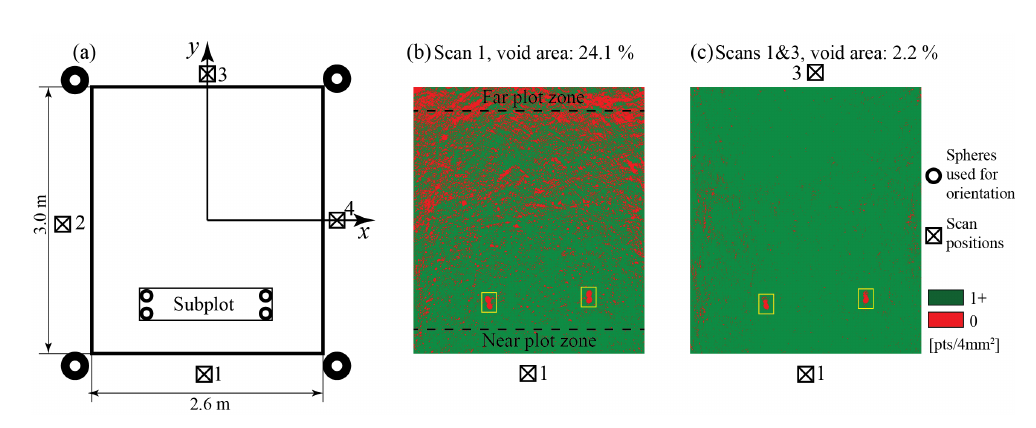
Figure 4. ( a ) The scheme of the scan positions with respect to the plot coordinate system.